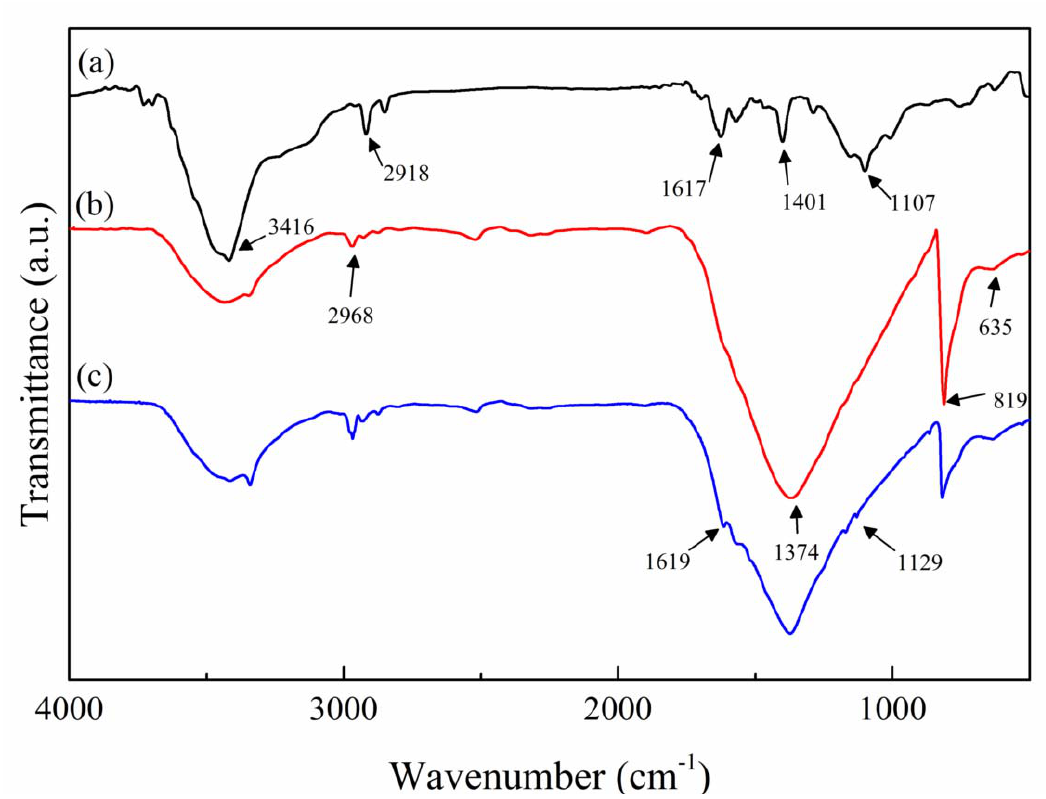
Figure 3. FT ‐ IR spectra of ( a ) a ‐ CNT; ( b ) f ‐ BN; and ( c ) BN@15CNT. Figure 3. FT-IR spectra of ( a ) a-CNT; ( b ) f-BN; and ( c ) BN@15CNT.